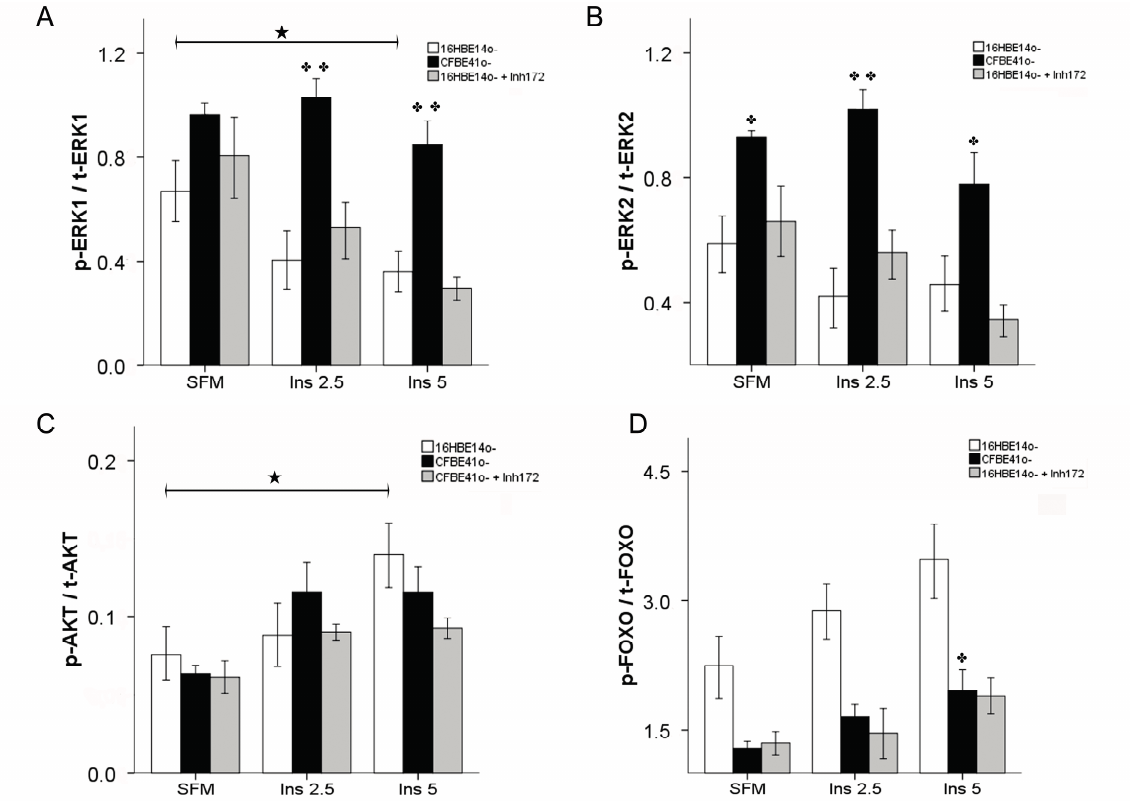
2.1.3. Effect of Treatment of 16HBE14o- Cells with a Cystic Fibrosis Transmembrane Conductance Regulator (CFTR) Inhibitor and CFTR Gene